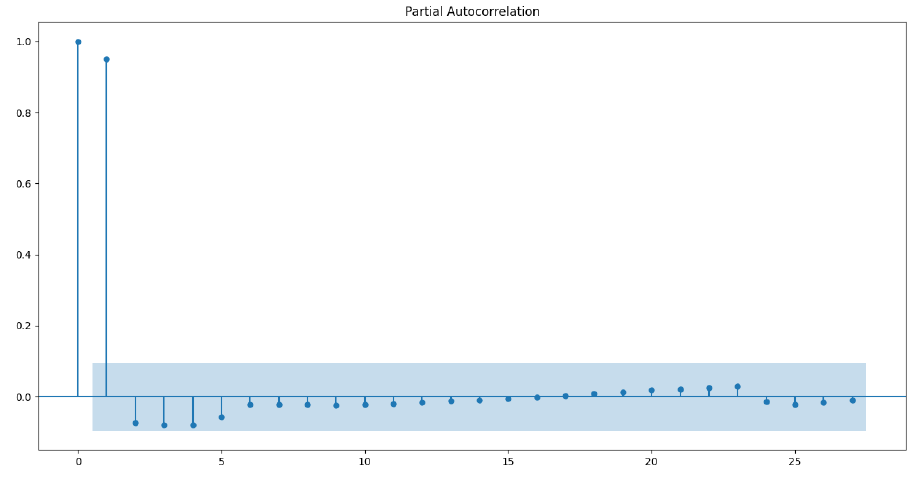
Figure 8. PACF (Partial Autocorrelation Function).